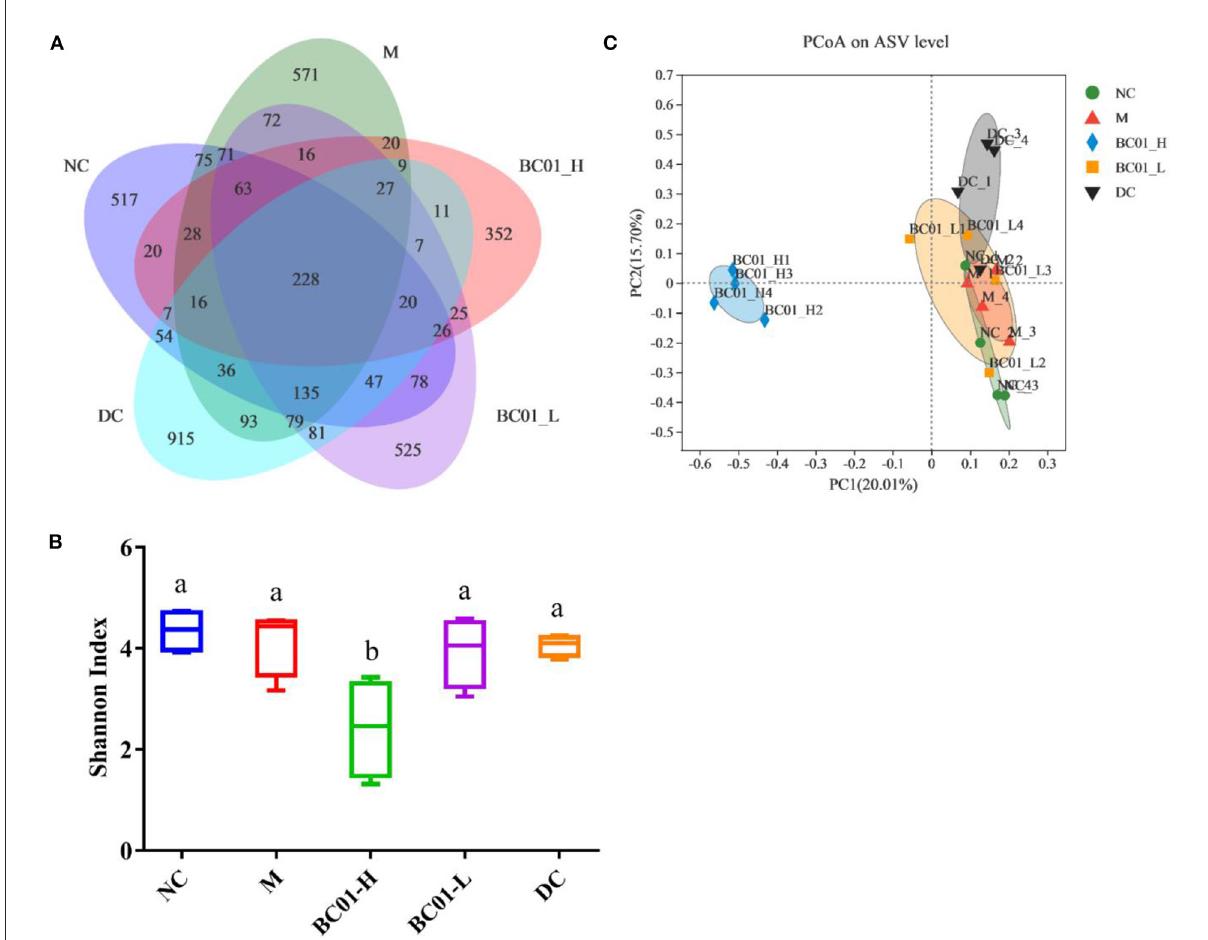
FIGURE6 Effects of BC01 on the intestinal microbiota composition in the constipated mice. (A) Venn plot of shared and unique ASVs in mouse gut microbiota. (B) Shannon index of the ASV level. (C) ASV level principal co-ordinates analysis using Bray-Curtis metrics. NC, normal group; M, constipation model group; DC, bisacodyl control group; BC01-H, B. coagulans BC01 high-dose group; BC01-L, B. coagulans BC01 low-dose group ( n =